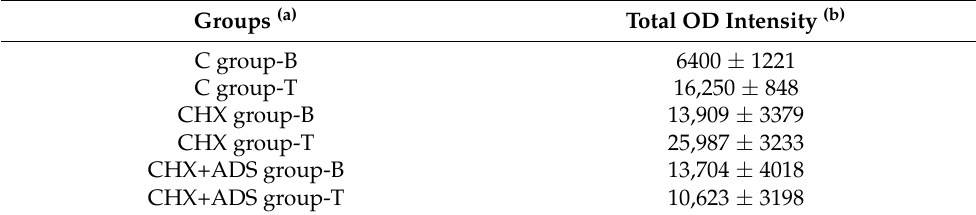
Table 1. Densitometric analysis of the protein bands.